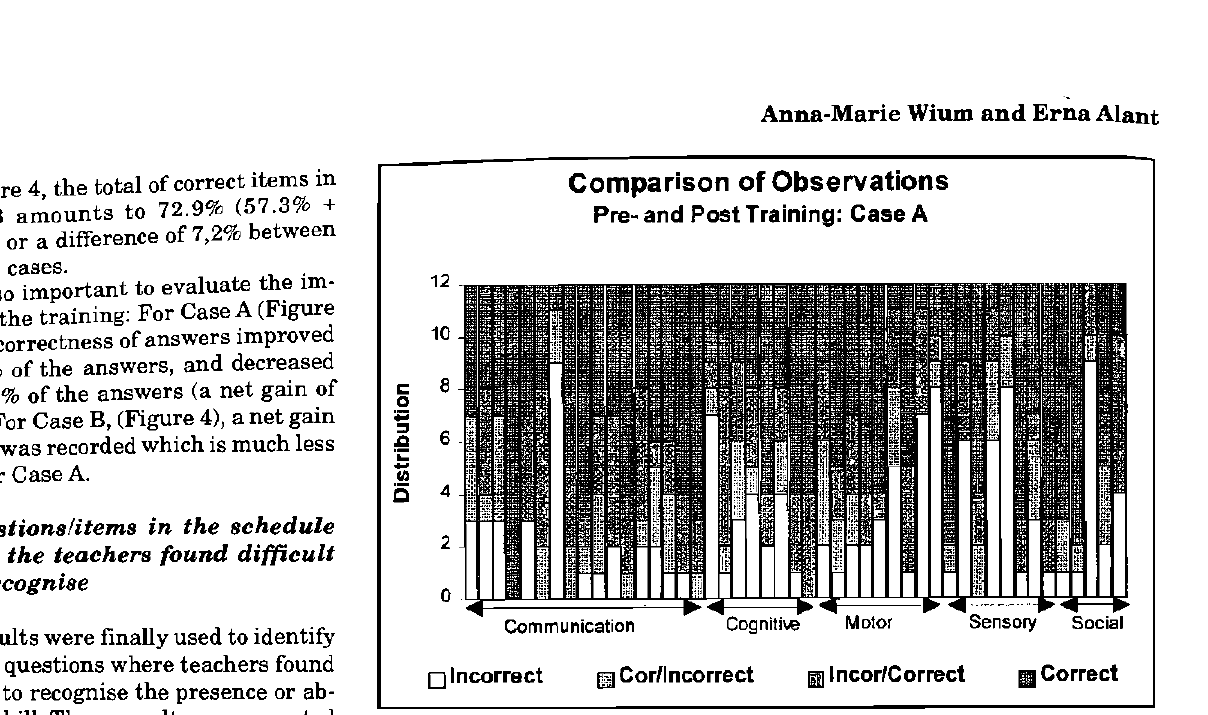
FIGURE 5. Difficult items to identify in observation A